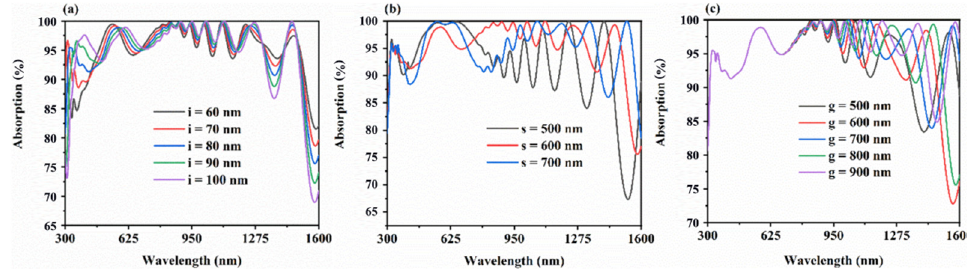
Figure 2. ( a ) Influence of ITO thickness of conductive glass on absorptivity. ( b ) Influence of organic layer of PEDOT:PSS thickness on absorptivity. ( c ) Influence of Ge base layer thickness on absorptivity.